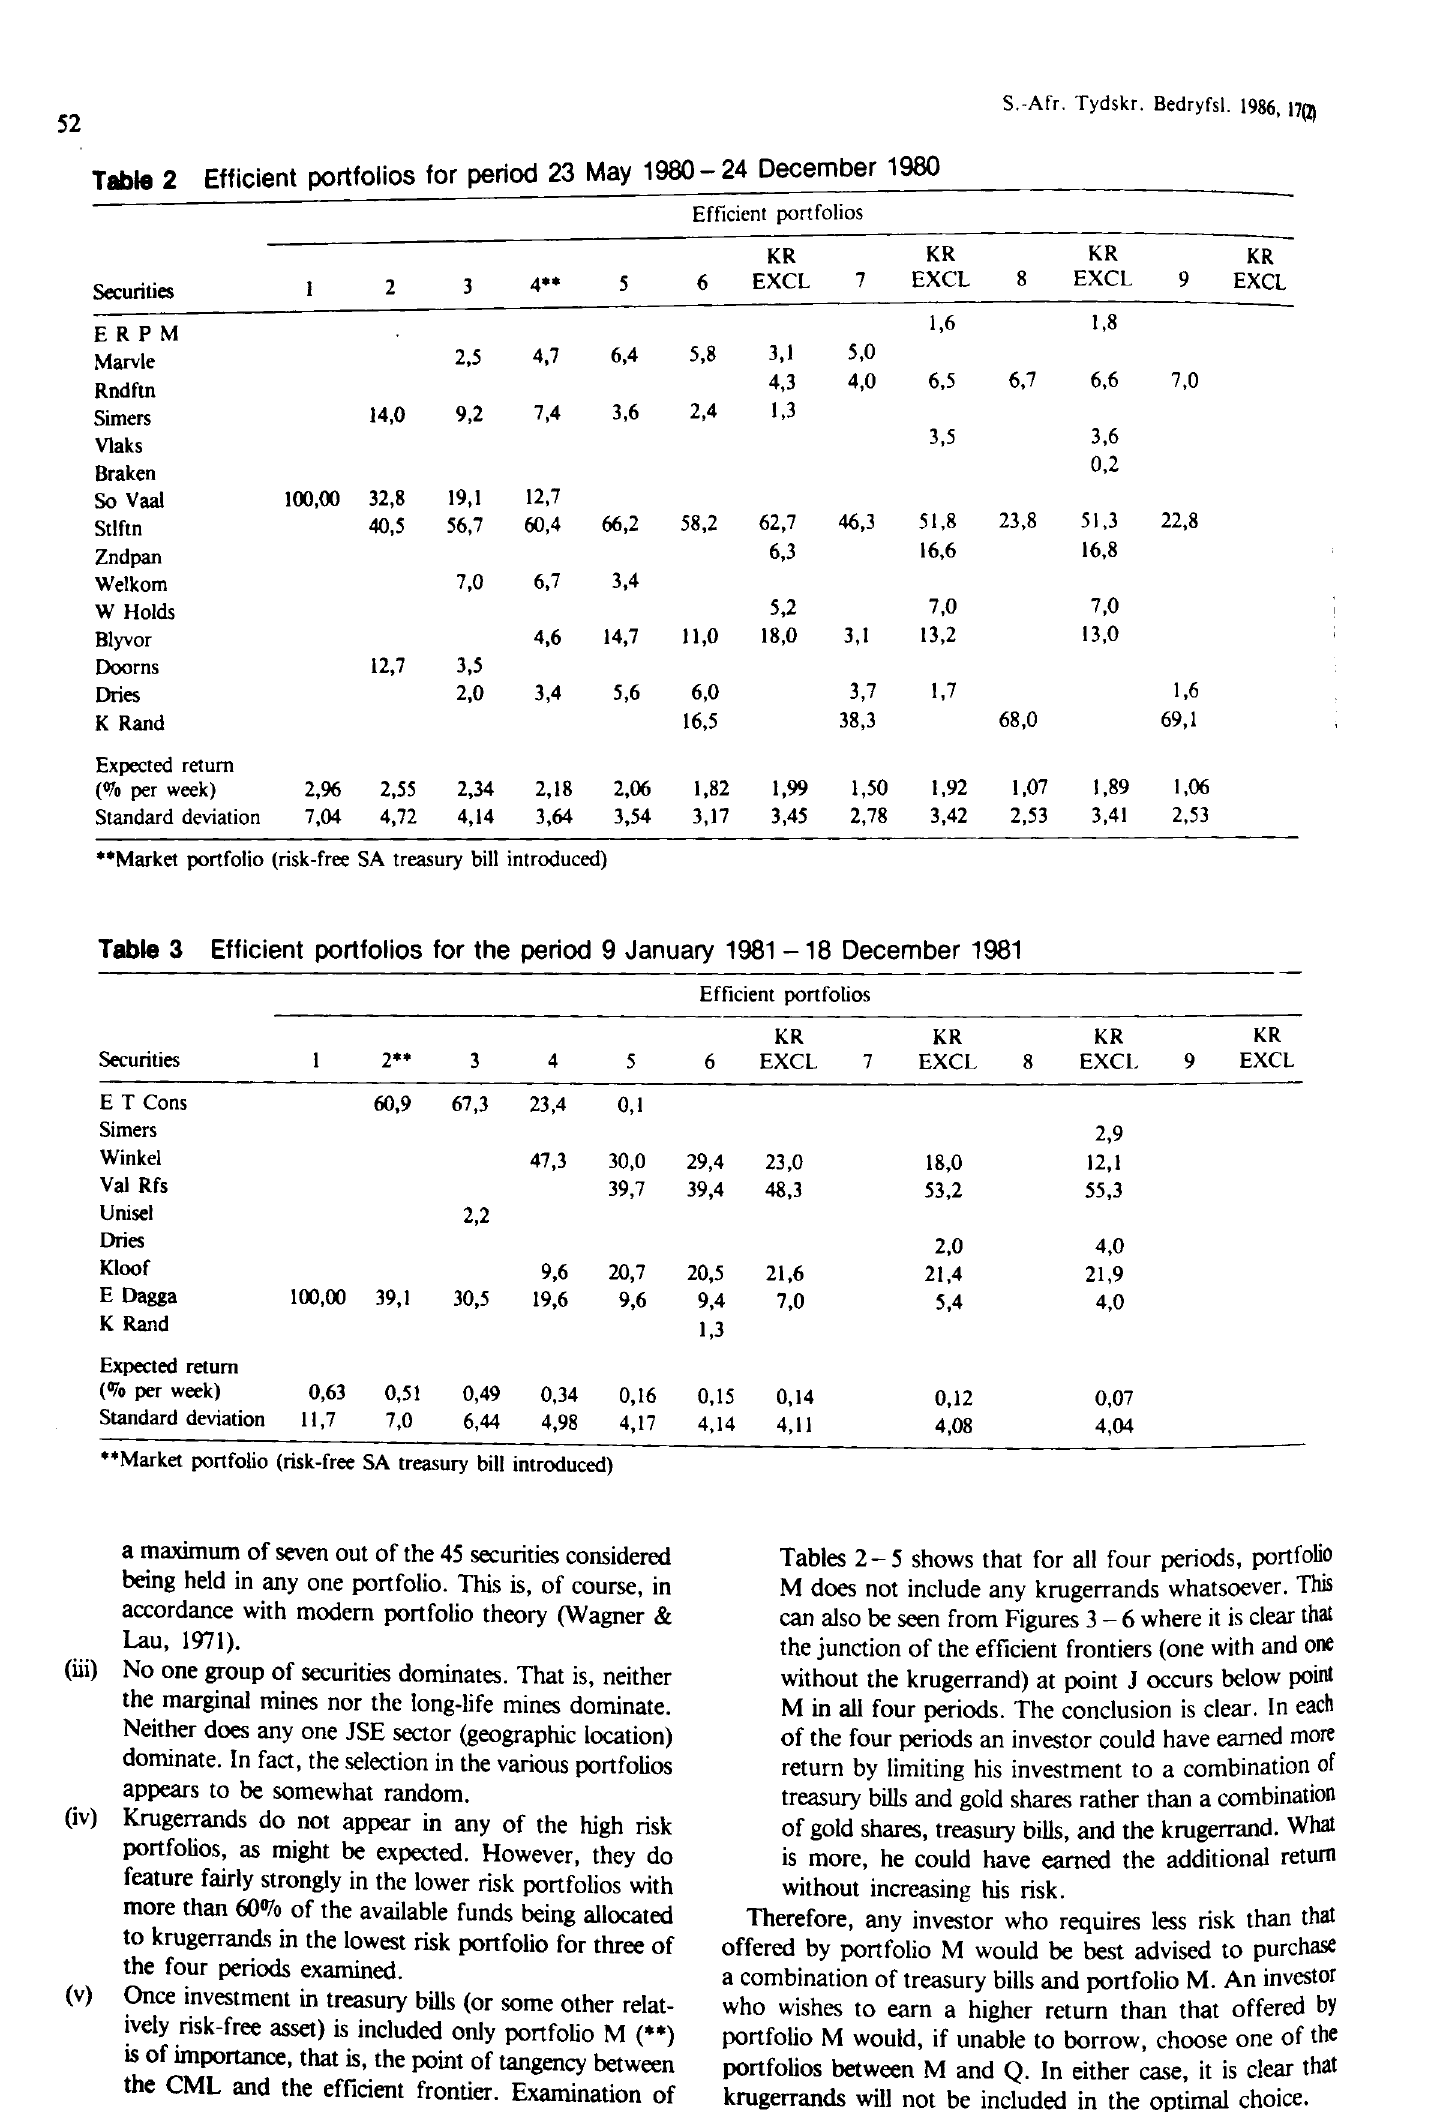
Efficient portfolios